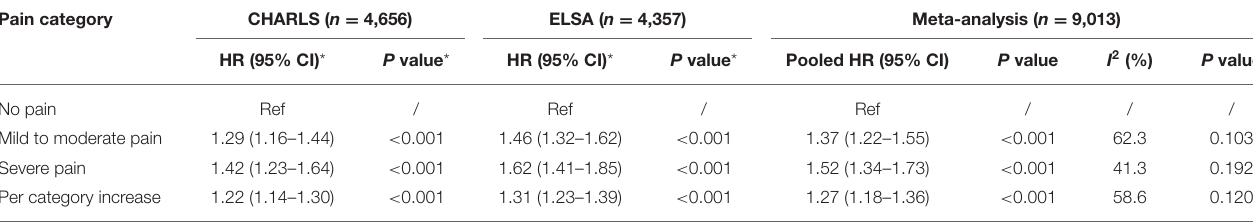
TABLE 2 | Association between baseline pain severity and incident depressive symptoms, using Cox regression models.